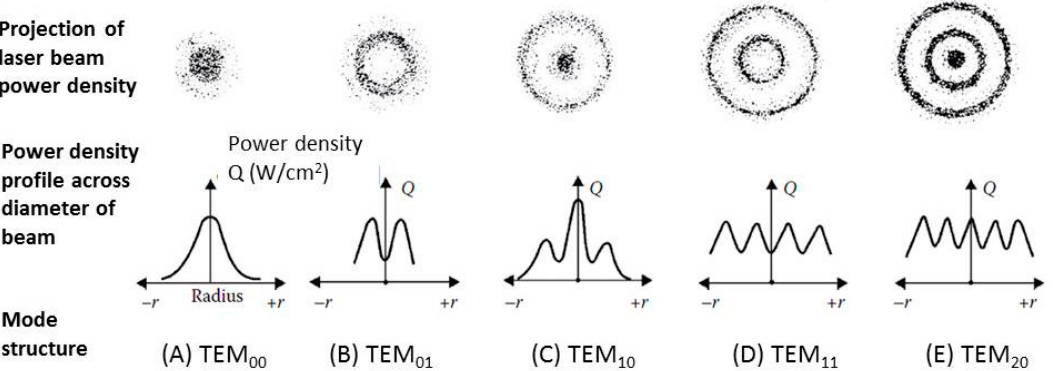
Figure 4. Heat source distributions of various transverse electromagnetic modes (TEM) [25].